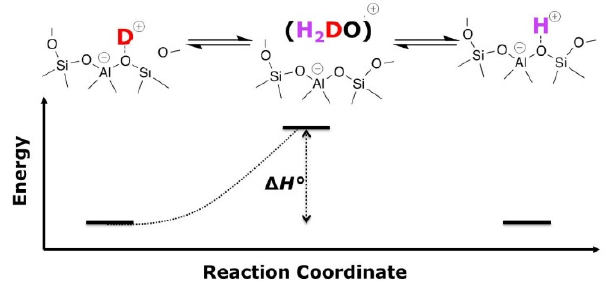
Figure 2. Illustration of a sequence of equilibria, of which the first half reaction is considered.